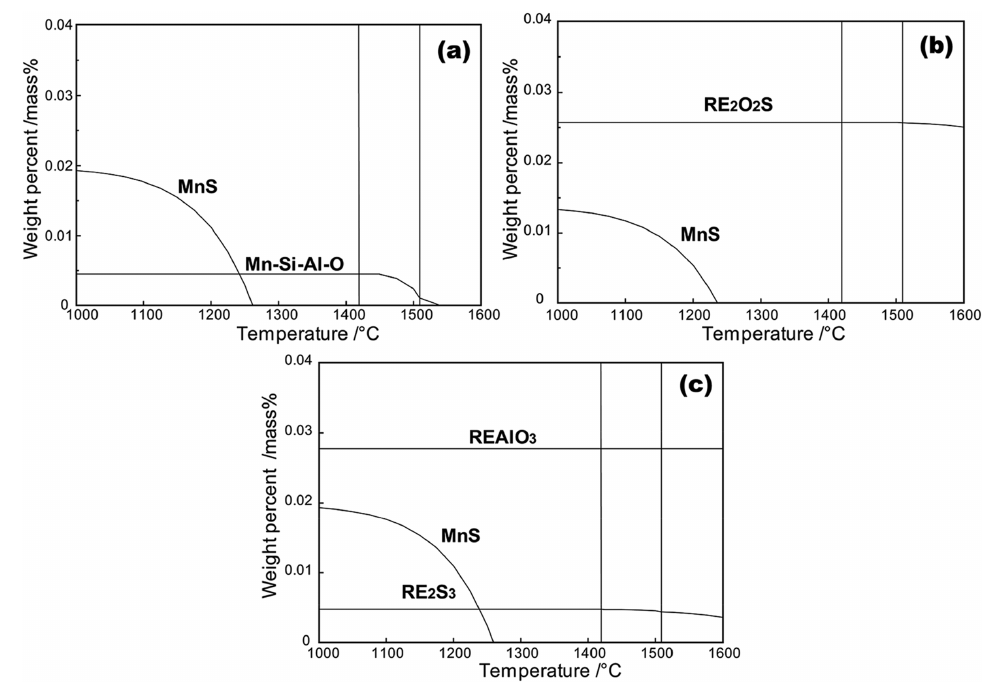
Figure 5: Calculated chemical composition of inclusions in steels, (a) steel No.1; (b) steel No.2; (c) steel No.3.